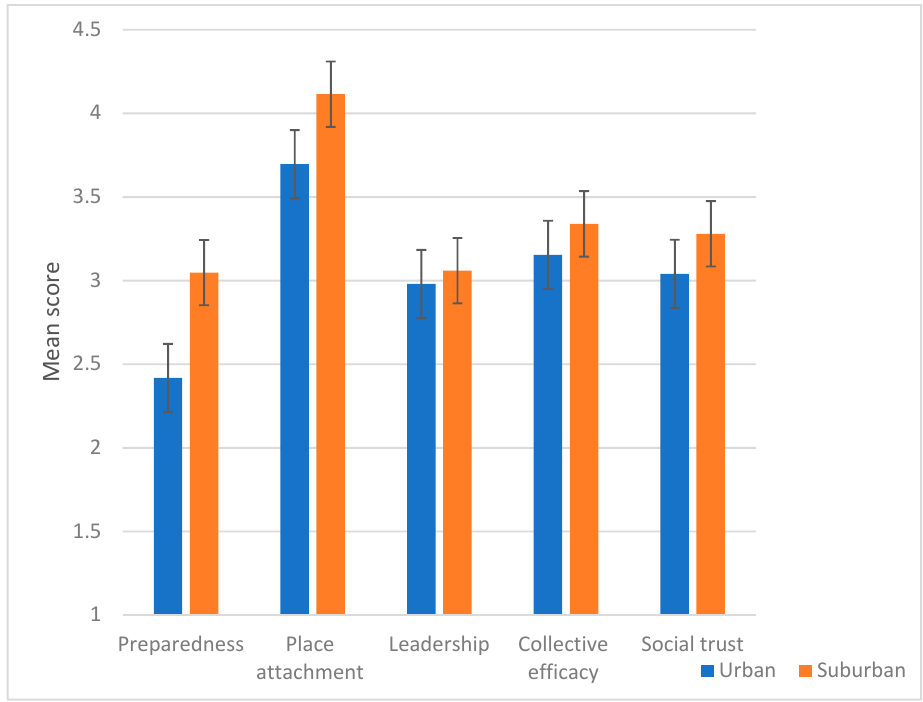
Figure 1. Differences between members of urban and suburban communities in the CCRAM factors. Figure 1. Di ff erences between members of urban and suburban communities in the CCRAM factors.